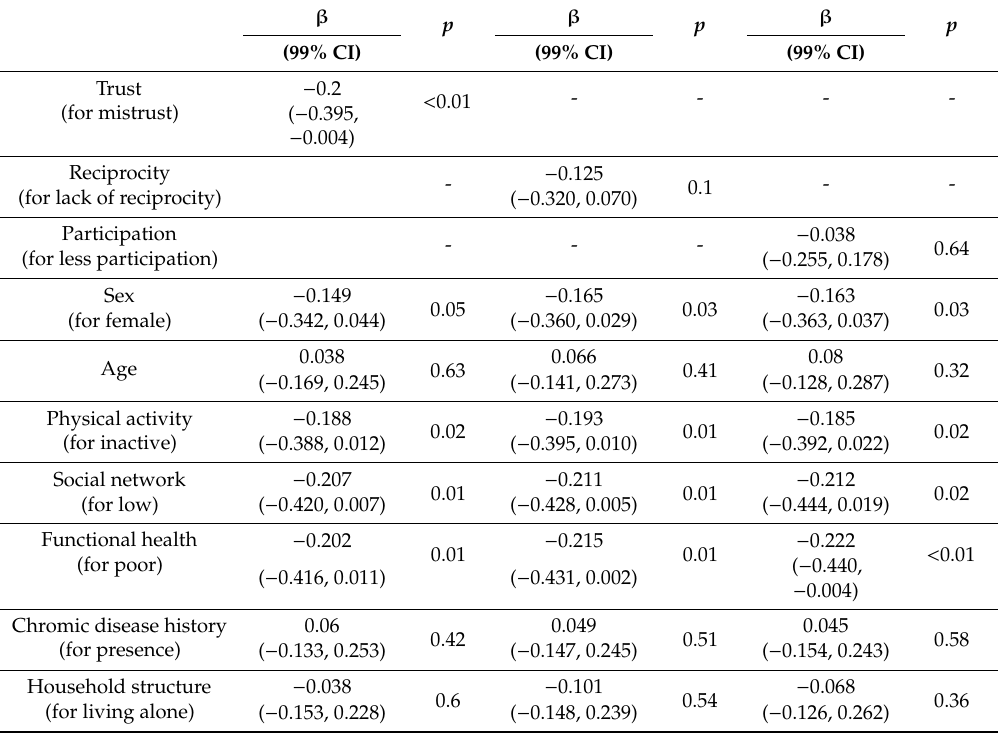
Table 5. The association between social capital and low SWB (non-RPH group; n = 159).